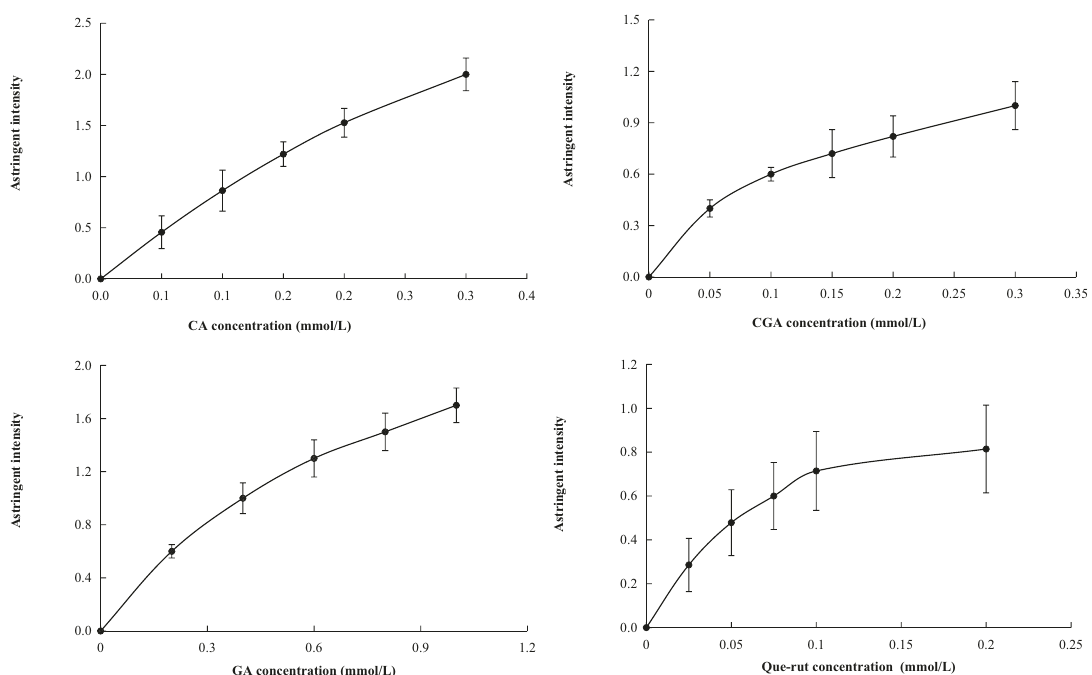
Fig. 1 Concentration-astringent intensity curves of the three phenolic acids and Que-rut. CA caffeic acid, CGA chlorogenic acid, GA gallic acid, Que-rut quercetin-3-O-rutinoside. Data are means (±SD) of three replicates. Table 3. Functions used for the phenolic acids and Que-rut concentration-astringent intensity curves.